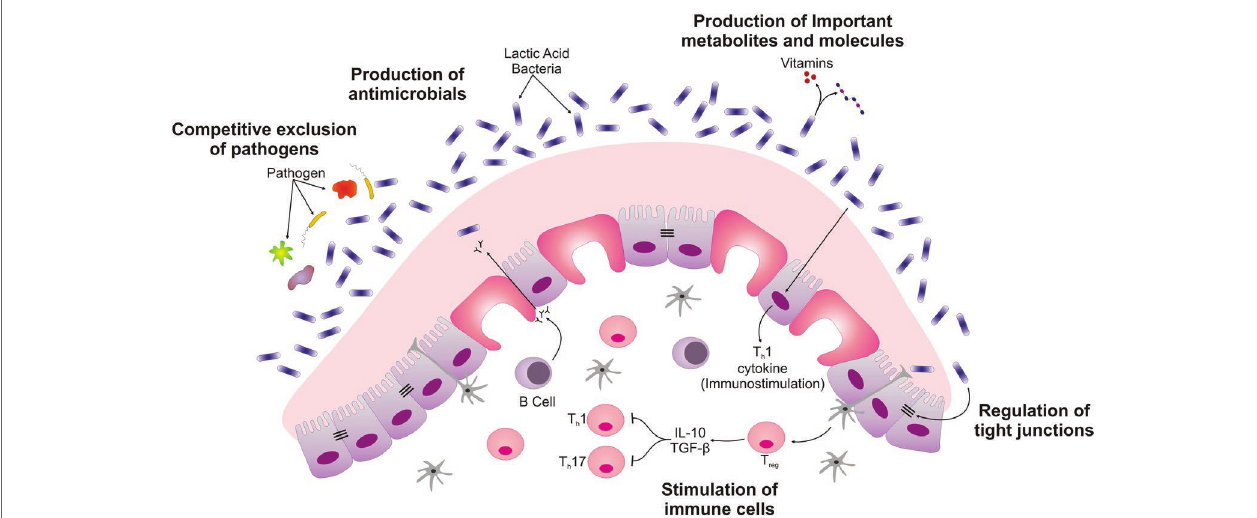
FIGURE 1 | Schematic displaying different ways by which probiotics exert their beneficial roles in intestine. LAB isolated from ethnic dairy product are responsible for competitive exclusion of pathogens, secretion of important metabolites and molecules such as bacteriocins. These Probiotics create mucus barrier by stimulating the Goblet cells. The interaction of Lactobacillus with intestinal epithelial cells also differentiates immune cell and regulates the barrier function of intestinal epithelial